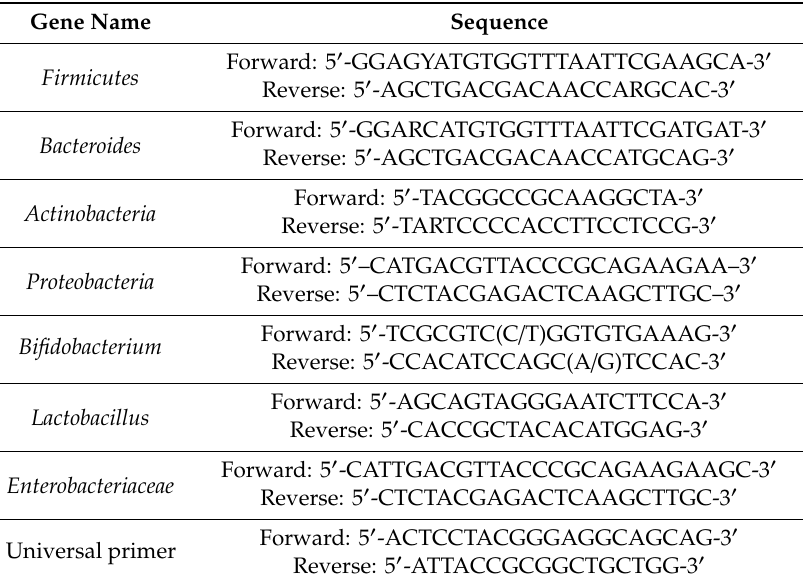
Table 2. Sequences of primers used for intestinal microbiota in mice